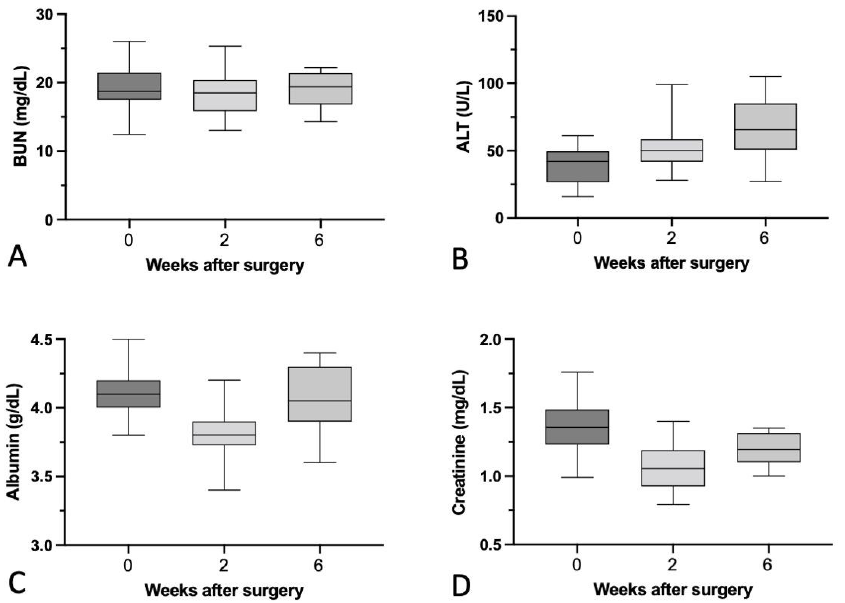
Figure 16. ( A ) Level of serum blood urea nitrogen (BUN; mg/dL), ( B ) level of serum alanine transaminase (ALT; U/L), ( C ) level of serum albumin (Alb; g/dL), and ( D ) level of creatinine (Cr; mg/dL) preoperation and 2 and 6 weeks postoperation. Mean ± SEM.